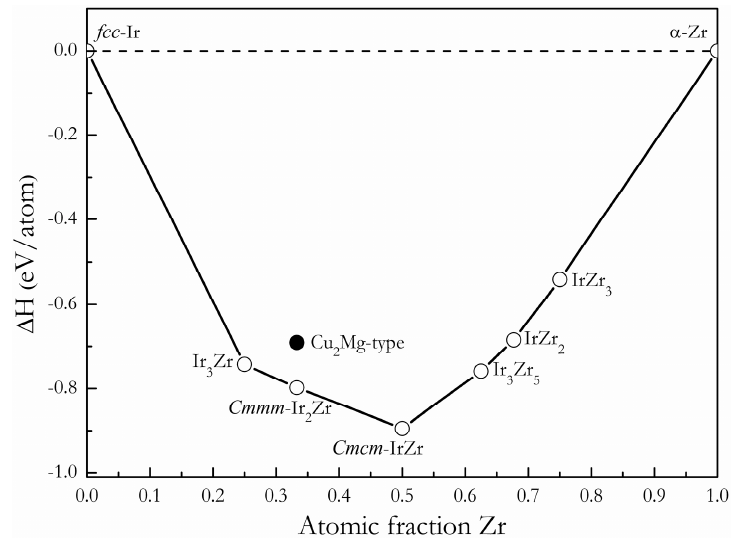
Figure 2. The formation enthalpy vs. composition curves for stoichiometric intermetallics in Ir-Zr system with fcc -Ir and α -Zr as reference states. The solid line denotes the ground state convex hull.